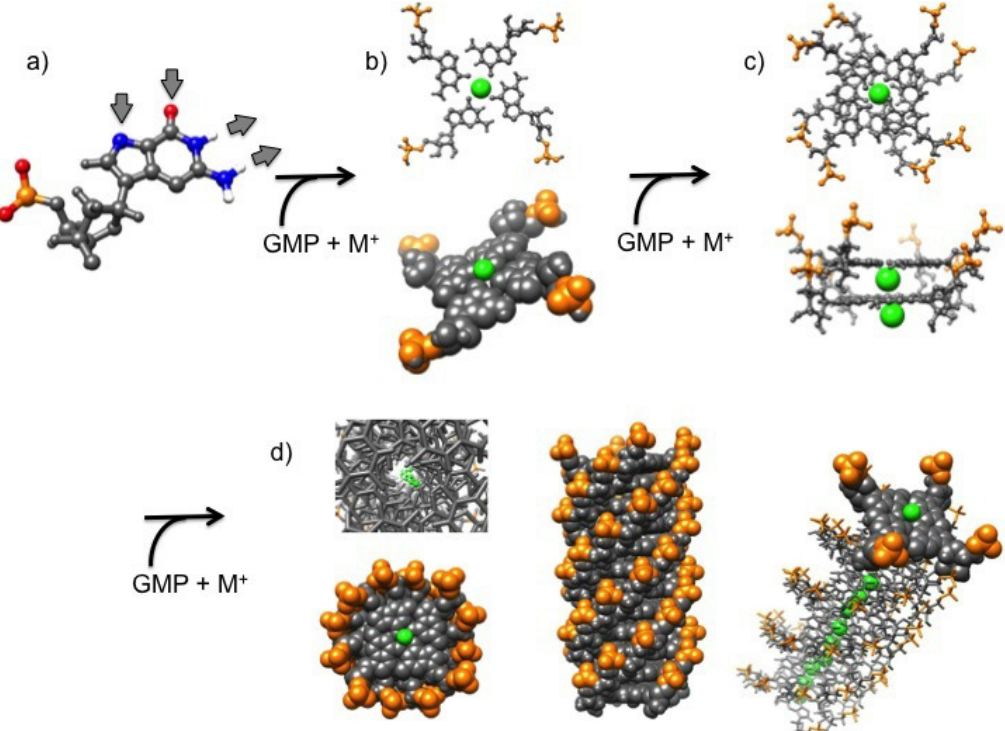
Figure 1. Guanosine self-assembly process in absence of axial backbone. Green: counterions (also indicated as M + ); orange: phosphate groups. ( a ) the guanosine 5’-monophosphate, GMP. The donor and acceptor groups are indicated by the arrows; ( b ) the G-quartet (ball-and-stick and van der Waals models); ( c ) the G-octamer (ball-and-stick model), top and lateral views; ( d ) the G-quadruplex (ball-and-stick and van der Waals models), top and lateral